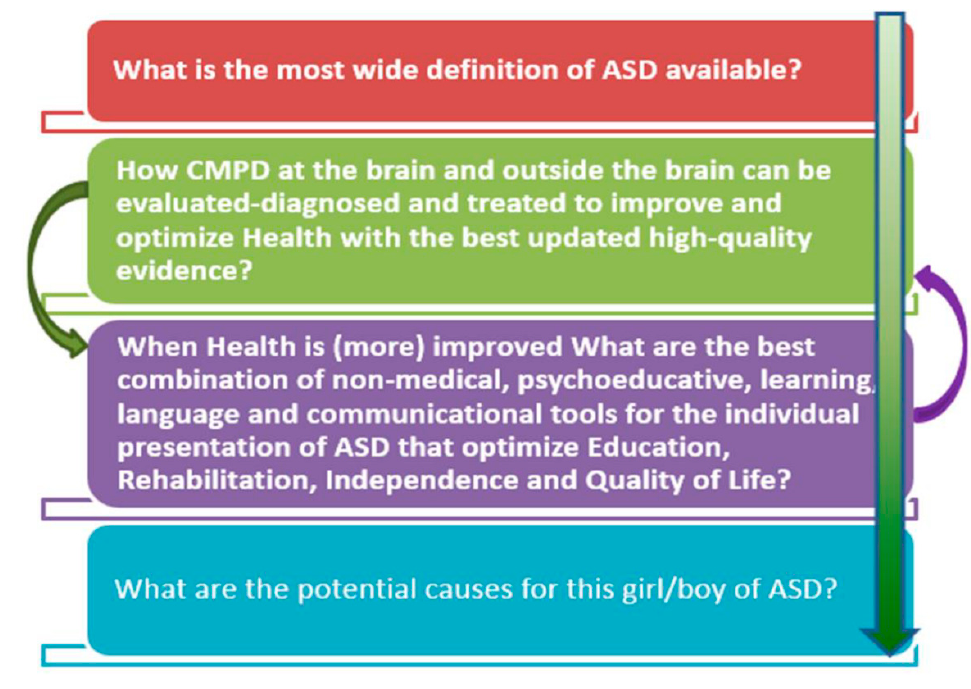
Figure 2. Main questions to present and to take into account